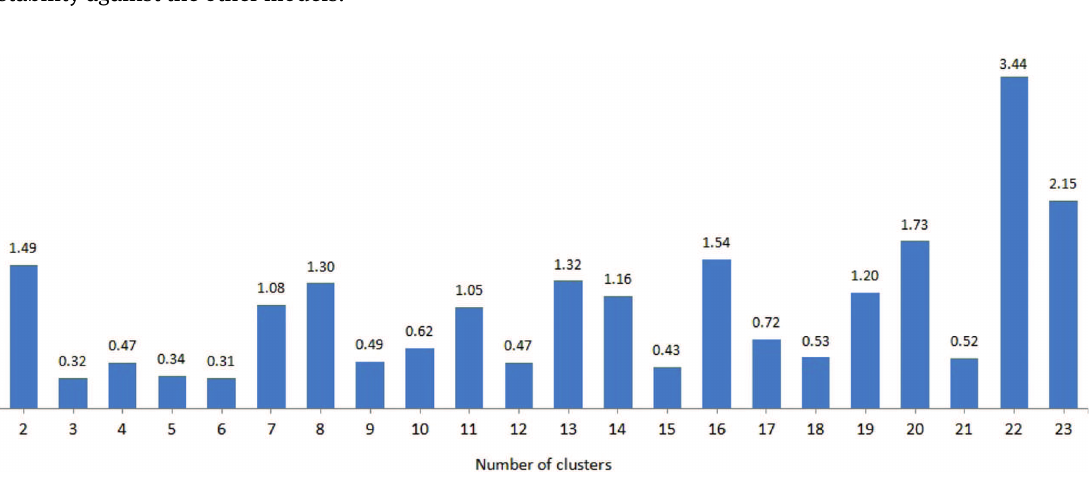
Figure 8: Results to Determine the Optimal Number of Clusters of FCM. Table 5: Performance of the Proposed Method against Other